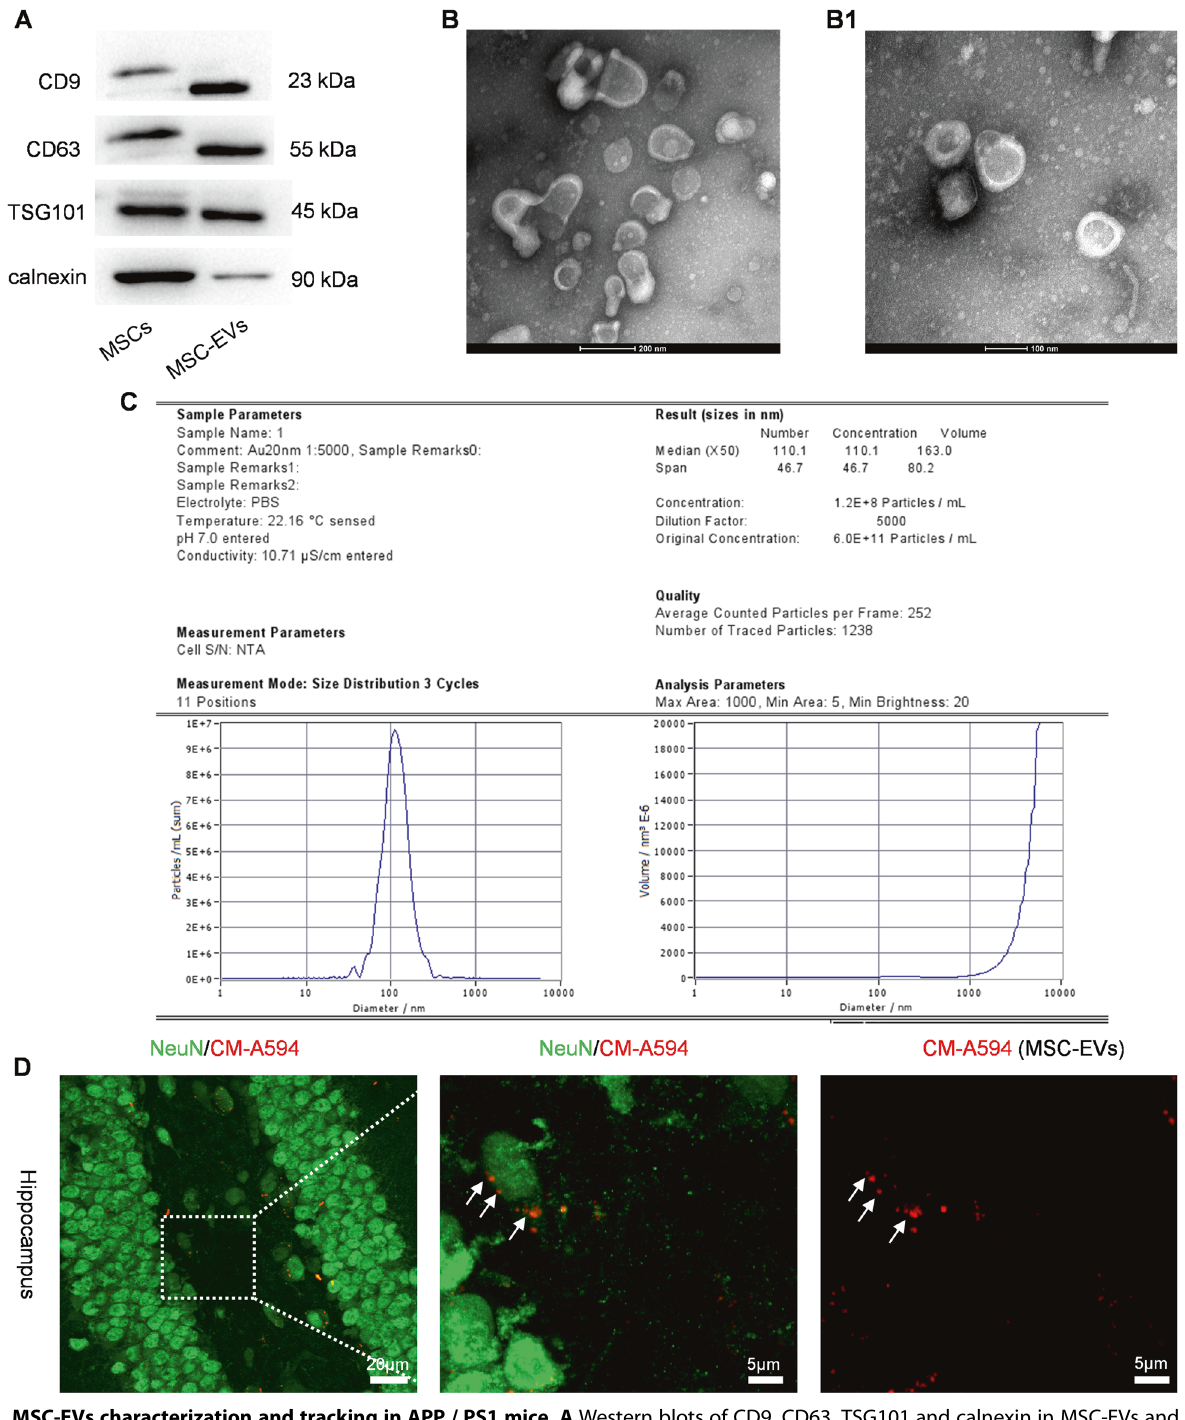
Fig. 1 MSC-EVs characterization and tracking in APP / PS1 mice. A Western blots of CD9, CD63, TSG101 and calnexin in MSC-EVs and MSCs (control). B , B1 transmission electron microscopy (TEM) images show the morphology of MSC-EVs ( B , bar = 200 nm; B1 , bar = 100 nm). C Nanoparticle tracking analysis (NTA) of size distribution for MSC-EVs. D Representative images show the location of C5 Maleimide-Alexa 594 (CM-A954) labeled MSC-EVs (red, white arrowheads) in the hippocampal neurons (green) in vivo (bar = 20 μ m), the square area appears with higher magni fi cation in the image on the right (bar = 5 μ treatment restores the excitability of hippocampal CA1 pyramidal waveform of hippocampal CA1 pyramidal neurons (Fig. 5H), we neurons in APP / PS1 mice. Importantly, mitochondria are essential found an increase in half-width (Fig. 5I, P < 0.05) and a decrease in for the maintenance of energy in hippocampal neurons [22]. We membrane potential (Fig. 5J, P < 0.05) and frequency (Fig. 5K, P < therefore examined the ultrastructure (Fig. S5A) and injury 0.01) of action potentials in the AD + saline group compared to markers (Fig. S5B) of mitochondria in each group. As shown in the WT mice, whereas EVs treatment signi fi cantly reversed (Fig. 6I- TEM images (Fig. S5A), the mitochondria in hippocampal neurons K, P < 0.05) these potential changes, suggesting that MSC-EVs